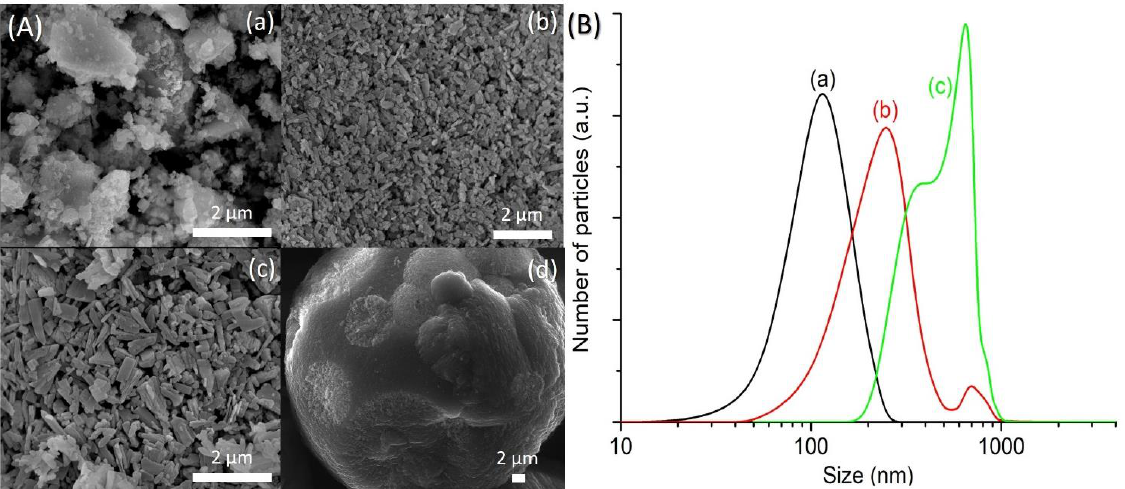
Figure 12. ( A ) SEM images and ( B ) particle size distributions of ( a ) SH18, ( b ) SH19, ( c ) SH4 and ( d ) SH20 prepared with a molar composition of 1Al 2 O 3 :2.5P 2 O 5 :2.5[bzmIm] 2 O:180H 2 O: 0.47SiO 2 . The samples were heated at 100, 120, 150 and 200 °C for 10 h, respectively.